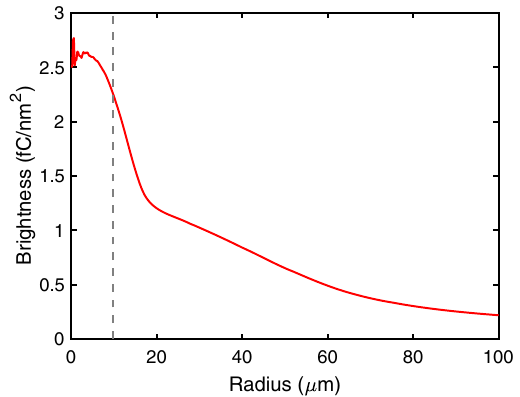
FIG. 9. Dependence of transverse brightness on the clipping aperture ’ s radius. The dashed line indicates the radius used in